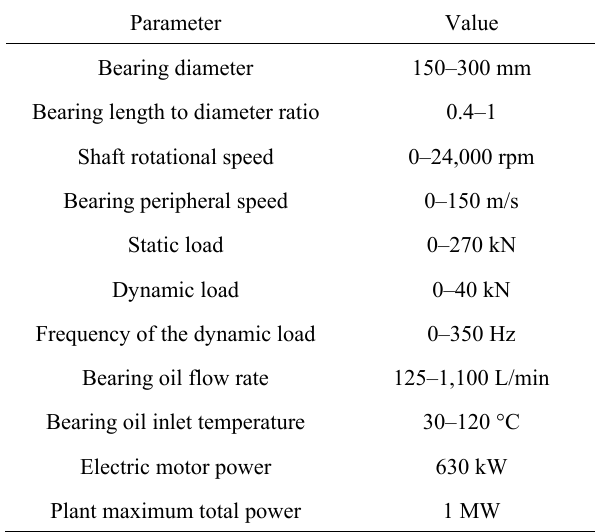
Table 1 Main parameters of tilting pad journal bearing test